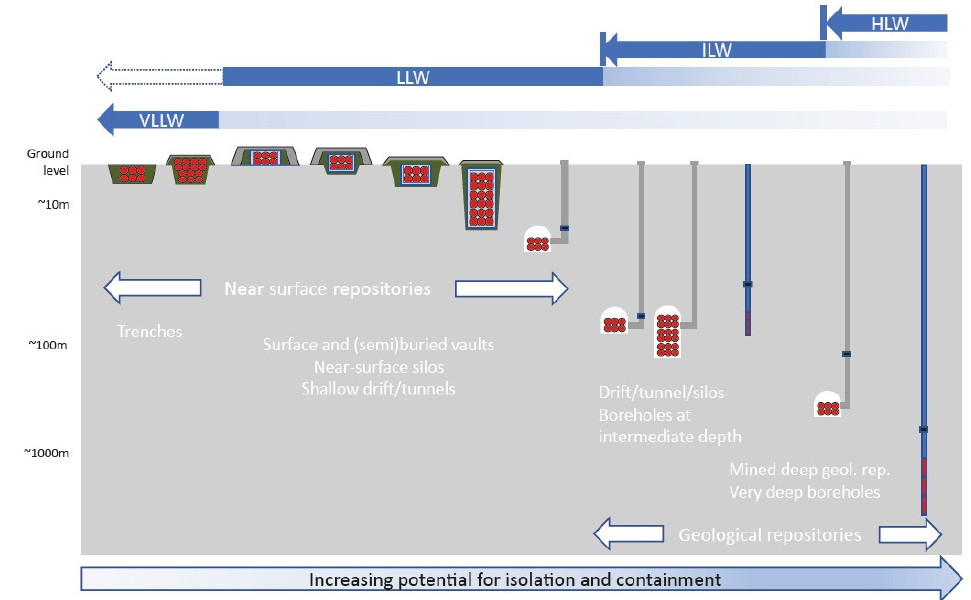
Figure 8. Illustration of graded approach in selection of nuclear waste disposal depth. Reproduced with permission of the IAEA from [11].